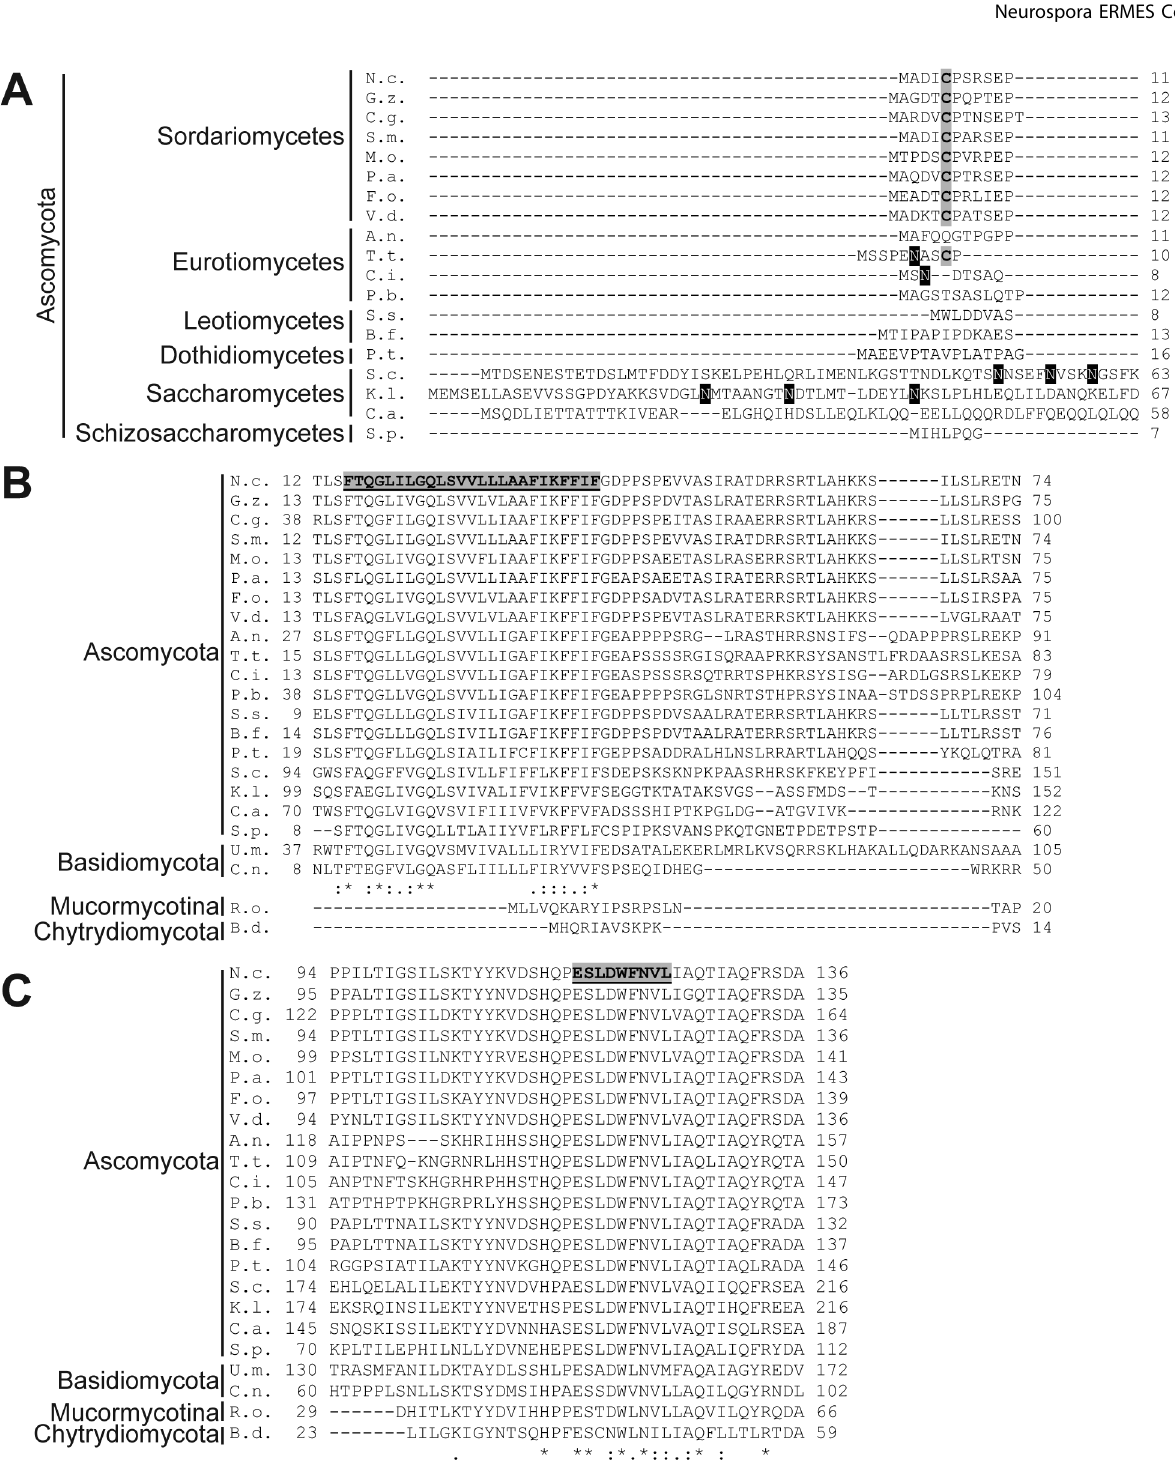
Figure 2. Alignments of fungal Mmm1 proteins. A. Alignment of Mmm1 N-terminal regions from several Ascomycetes. Known S. cerevisiae (N50, N55 and N59) [12] and potential N-glycosylation sites in other species are highlighted in black. Cys residue conserved in Sordariomycetes is shaded in grey. B. Predicted transmembrane domain of Mmm1is present in most fungi, but absent in Mucormycotina and Chytridiomycota. The predicted N. crassa transmembrane domain is highlighted in grey. Identity/similarity symbols are for the alignment of the Ascomycota and Basidiomycota only. * indicates conserved residues, : indicates conservation of groups with strongly similar properties (score of . 0.5 in the Gonnet PAM 250 matrix),. indicates conservation of groups with weakly similar properties (score of , 0.5 in the Gonnet PAM 250 matrix). C. Alignment of the highly conserved region of Mmm1 chosen for mutation analysis. The nine amino acid region that was chosen for mutation is highlighted in the N. crassa protein (residues 116-124). Symbols (as in panel B) are for the alignment of all proteins. Abbreviations: N.c., Neurospora crassa ; G.z., Gibberella zeae ; C.g., Chaetomium globosum ; S.m., Sordaria macrospora ; M.o., Magnaporthe oryzae ; P.a., Podospora anserina ; F.o. Fusarium oxysporum ; V.d., Verticillium dahliae ; A.n., Aspergillus nidulans ; T.t., Trichophyton tonsurans ; C.i., Coccidioides immitis ; P.b., Paracoccidioides brasiliensis ; S.s., Sclerotinia sclerotiorum ; B.f., Botryotinia fuckeliana ; P.t., Pyrenophora teres ; S.c., Saccharomyces cerevisiae ; K.l., Kluyveromyces lactis ; C.a., Candida albicans ; S.p., Schizosaccharomyces pombe ; U.m., Ustilago maydis ; C.n., Cryptocuccus neoformans ; R.o., Rhizopus oryzae ; B.d., Batrachochytrium dendrobatidis . doi:10.1371/journal.pone.0071837.g002 PLOS ONE |